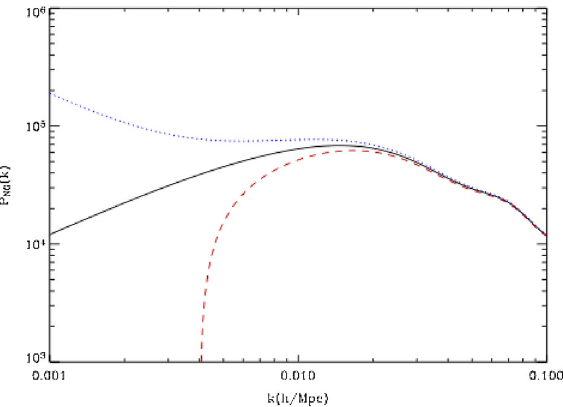
Fig. 53 For illustration purposes this is the effect of a local f NL of ± 50 on the z = 0 power spectrum of halos with mass above 10 13 M (cid:20)